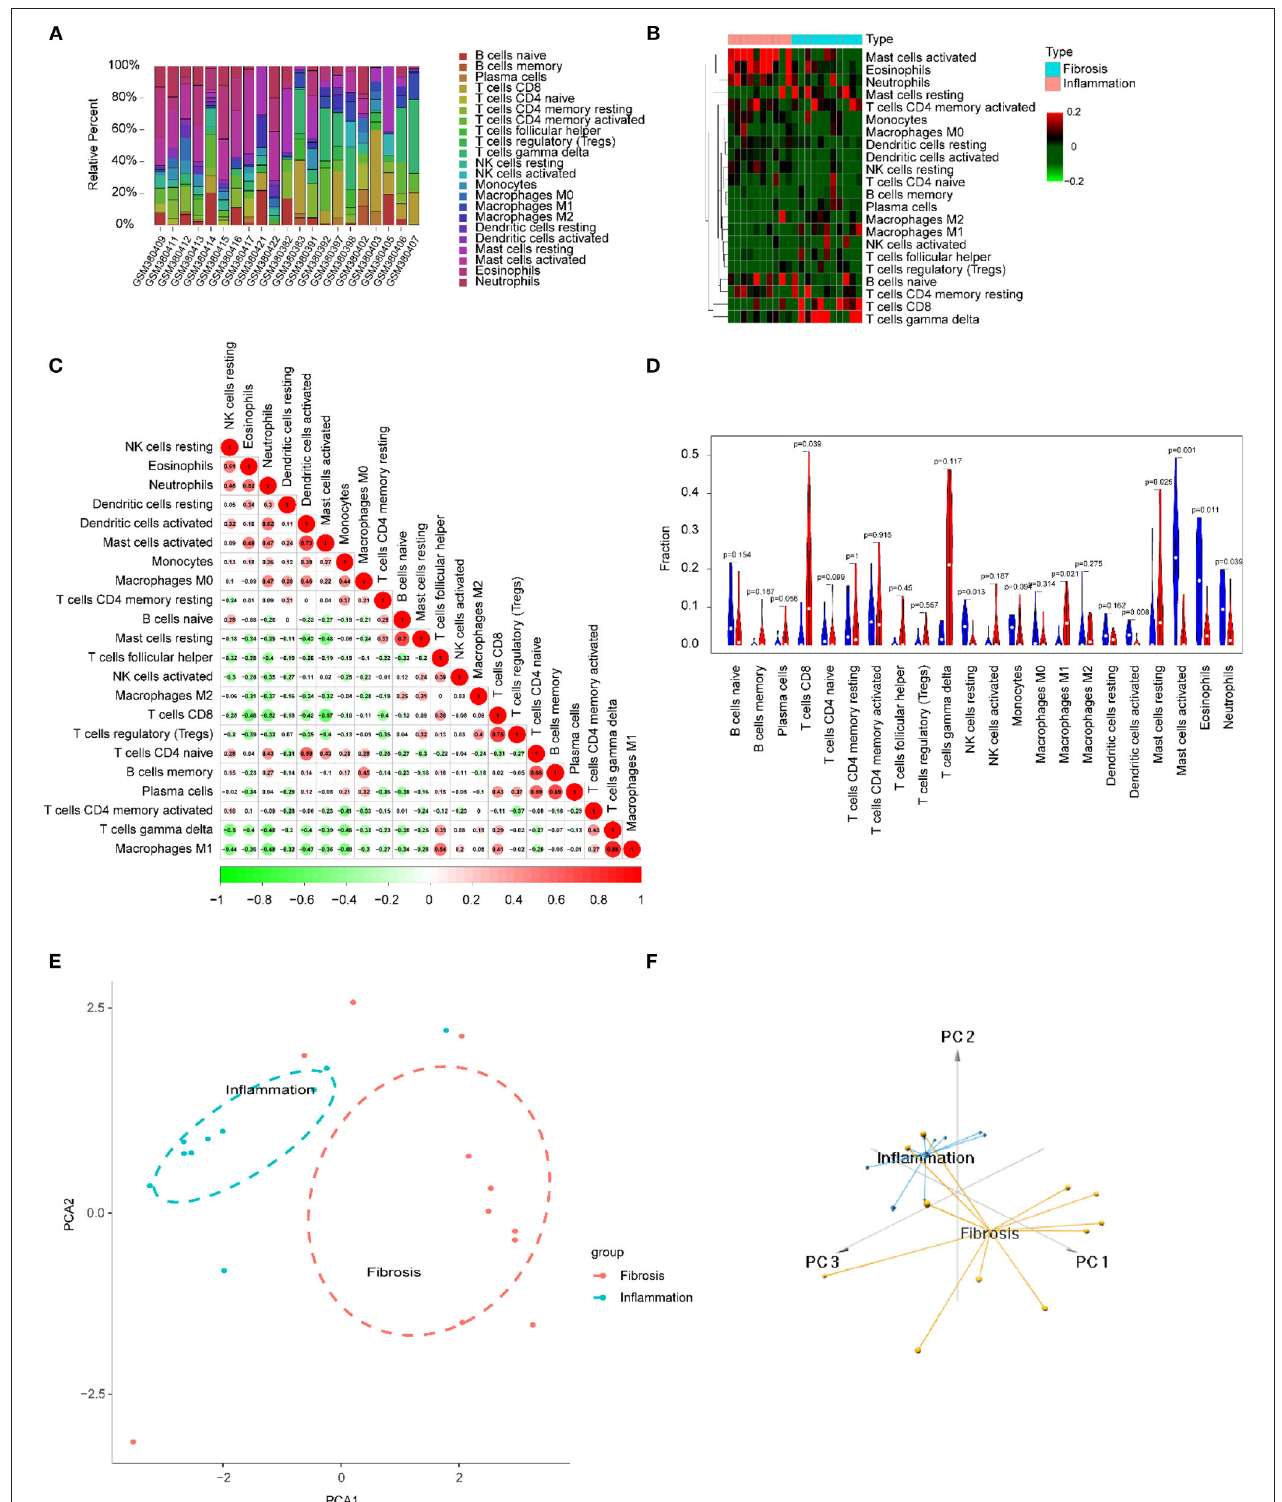
FIGURE 8 | Immune cells infiltrating the livers with inflammation and fibrosis in BA. (A) The barplot reflects the relative content of 22 immune cells in each sample. (B) Heatmap of the 22 immune cell proportions. (C) Correlation heatmap of 22 immune cells. The size of the colored circles represents the strength of the correlation; red represents a positive correlation, and green represents a negative correlation. (D) Violin diagram of the proportion of 22 types of immune cells among the different groups. (E,F) PCA cluster plot of immune cell infiltration between inflamed and fibrotic livers of BA samples.